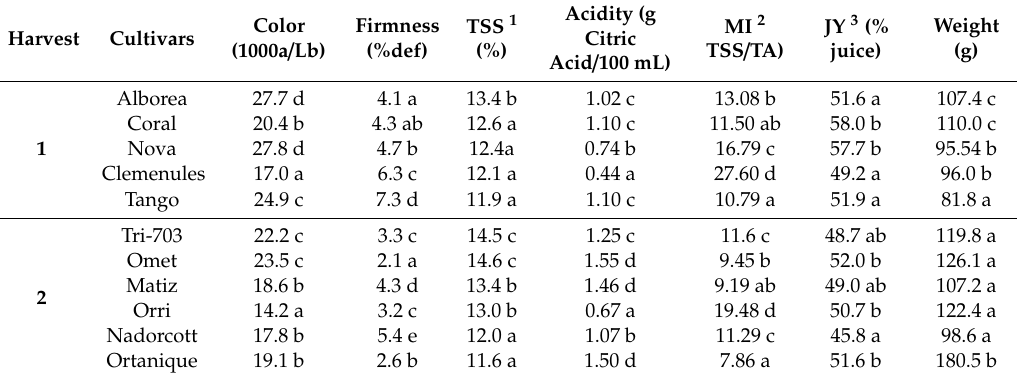
Table 1. Physico-chemical parameters of the eleven mandarin